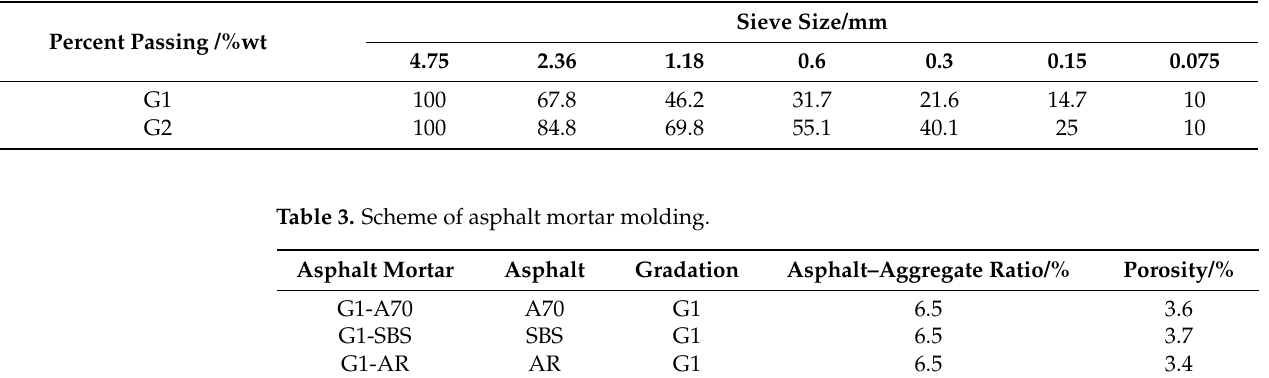
Table 2. Gradation of aggregates used in the study.